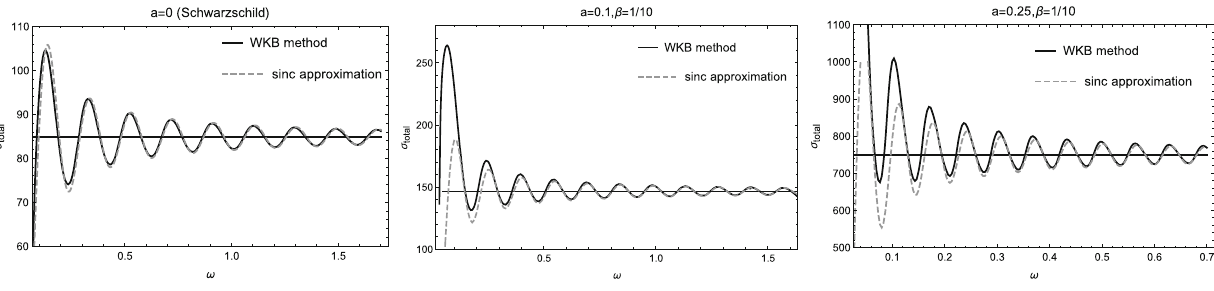
Fig. 4 For β > 0 and M = 1, the total absorption cross section for the variable a at β = 1